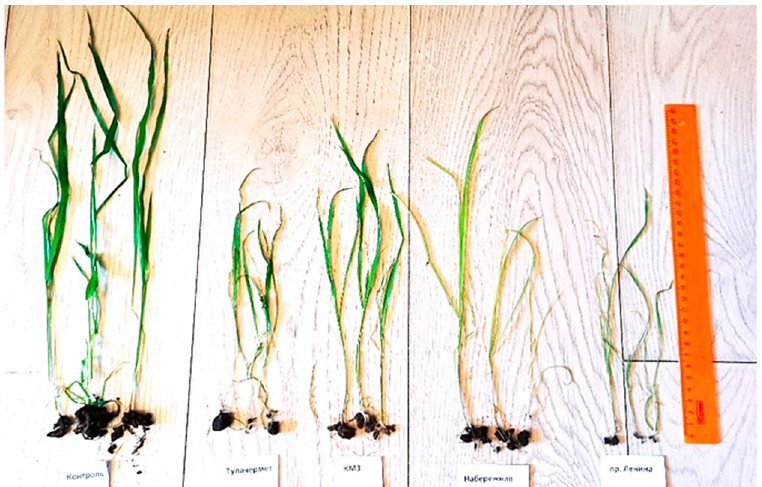
Figure A1. Echinochloa frumentacea shoots (1.5 monthly) grown on the soils of the experimental zones: from left to right: background, Tulachermet, KMP, Embankment, highway (Lenin Ave.).